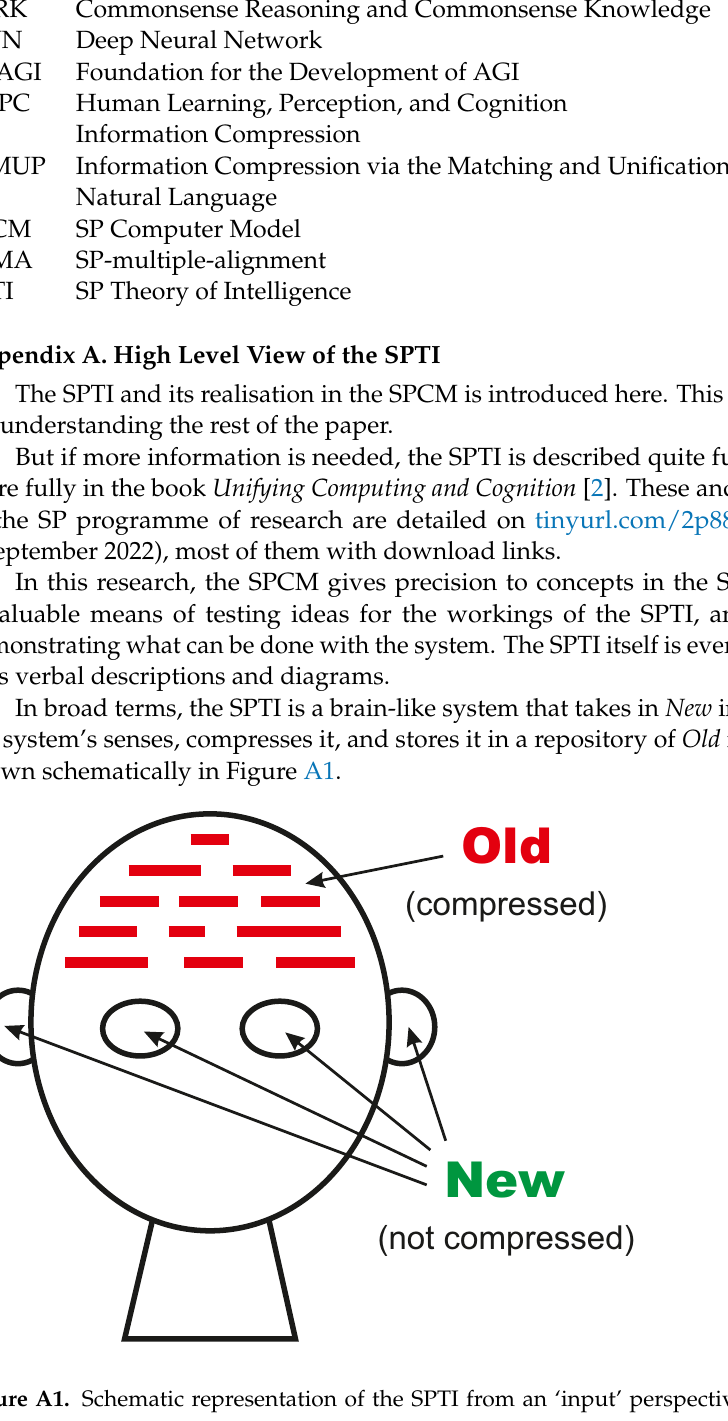
Figure A1. Schematic representation of the SPTI from an ‘input’ perspective. Reproduced from Figure 1 in